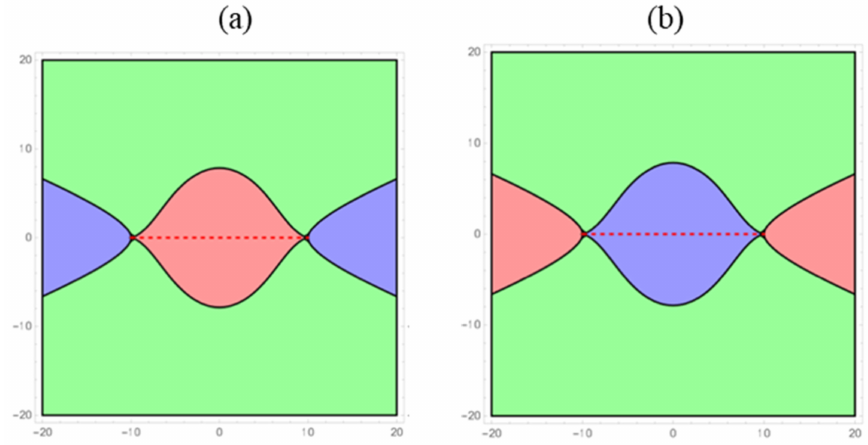
Figure 14. Stress state maps for ( a ) over-pressured hydraulic fracture and ( b ) under-pressured hydraulic fracture. Red regions have σ 1 and σ 3 both compressive, blue regions have σ 1 and σ 3 both tensile, and green regions have σ 1 compressive and σ 3